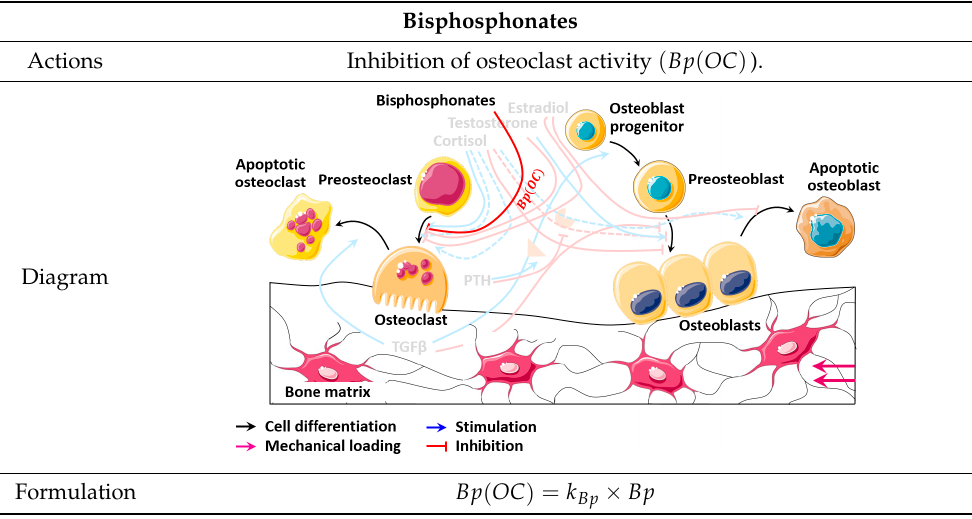
Table 6. Bisphosphonate actions and their mathematical formulation.